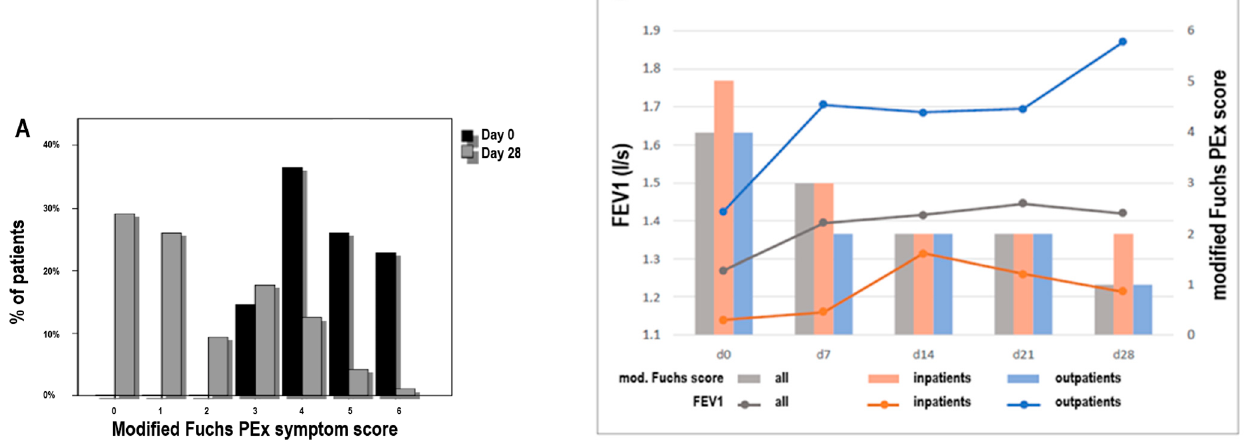
Figure 4. ( A ) Modified Fuchs BEx symptom score day 0 + day 28. Change between Day 0 and Day 28, % of patients. ( B ) Home spirometry + modified Fuchs BEx symptom score, day 0–28. The mean home spirometry FEV1 and Fuchs score from the start of therapy (day 0) and over the whole follow-up period (days 7, 14, 21, and 28) is presented for all patients (grey) and separately for inpatients (orange) and outpatients (blue).